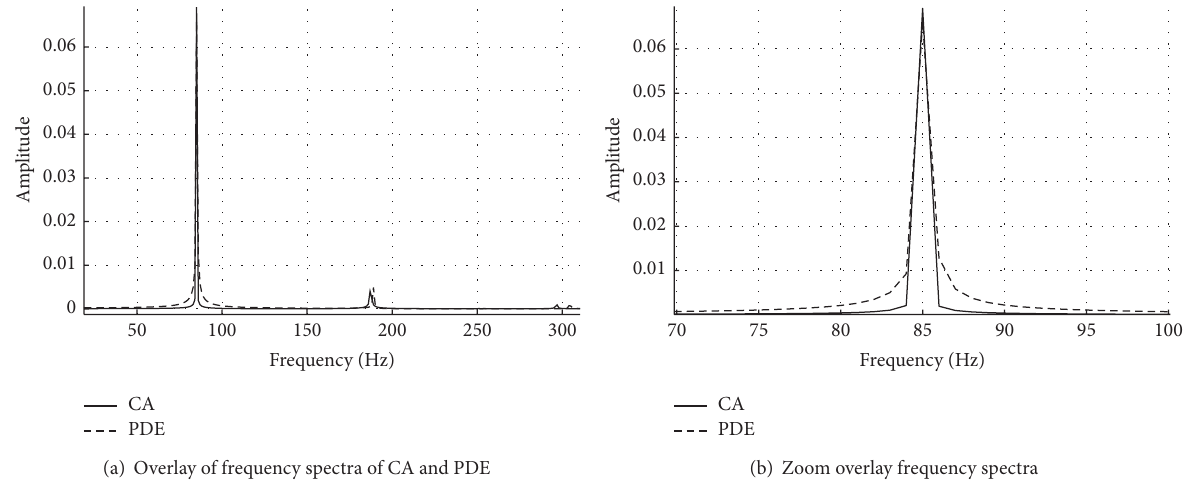
Figure 9: Graphic of frequency spectra overlay (a) of the simulation realized by the CA and the PDE, (b) zoom-in of the graphic overlay.